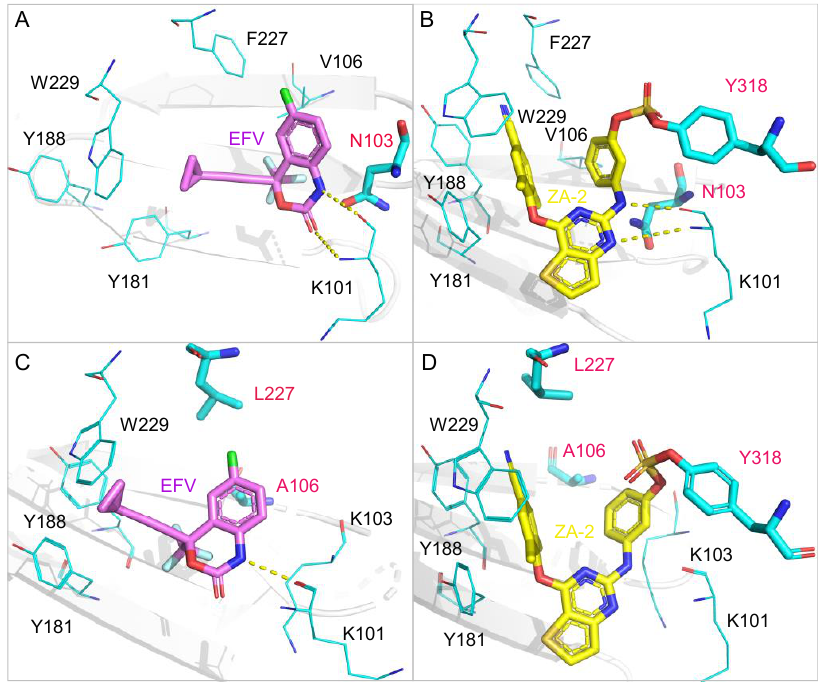
Figure 4. ( A ) The crystal structure of EFV and K103N HIV-1 RT and ( B ) predicted binding modes of ZA-2 with K103N HIV-1 RT (PDB code: 1IKV), ( C ) EFV with F227L/V106A HIV-1 RT and ( D ) ZA-2 with F227L/V106A HIV-1 RT (PDB code: 6DUF) [19,20]. All hydrogen bonds are shown as yellow dotted lines. Nonpolar hydrogen atoms are not shown for clarity.